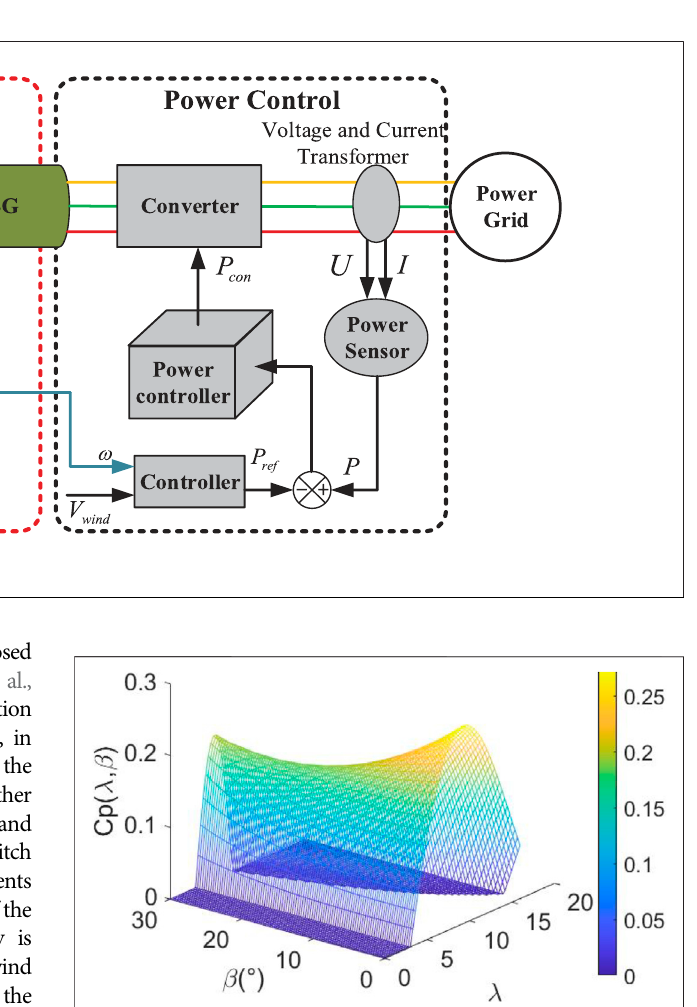
FIGURE 2 | The curve of wind turbine ’ s power coef fi